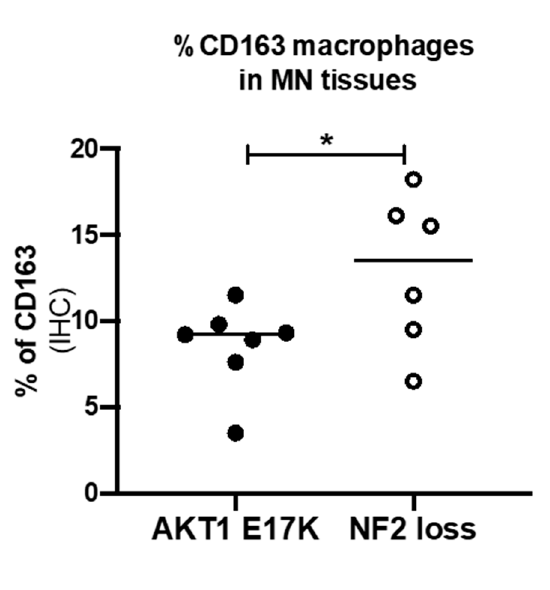
Figure 4. (a) Representative immunohistochemistry images for CD163-stained macrophages in AKT1 E17K- and NF2-negative meningioma (MN) tissue sections, ×100 magnification (b) % of CD163+ cells in AKT1 E17K mutants ( n = 7) compared to WHO grade I NF2-negative ( n = 6) meningiomas by IHC; line represents the median, * p <